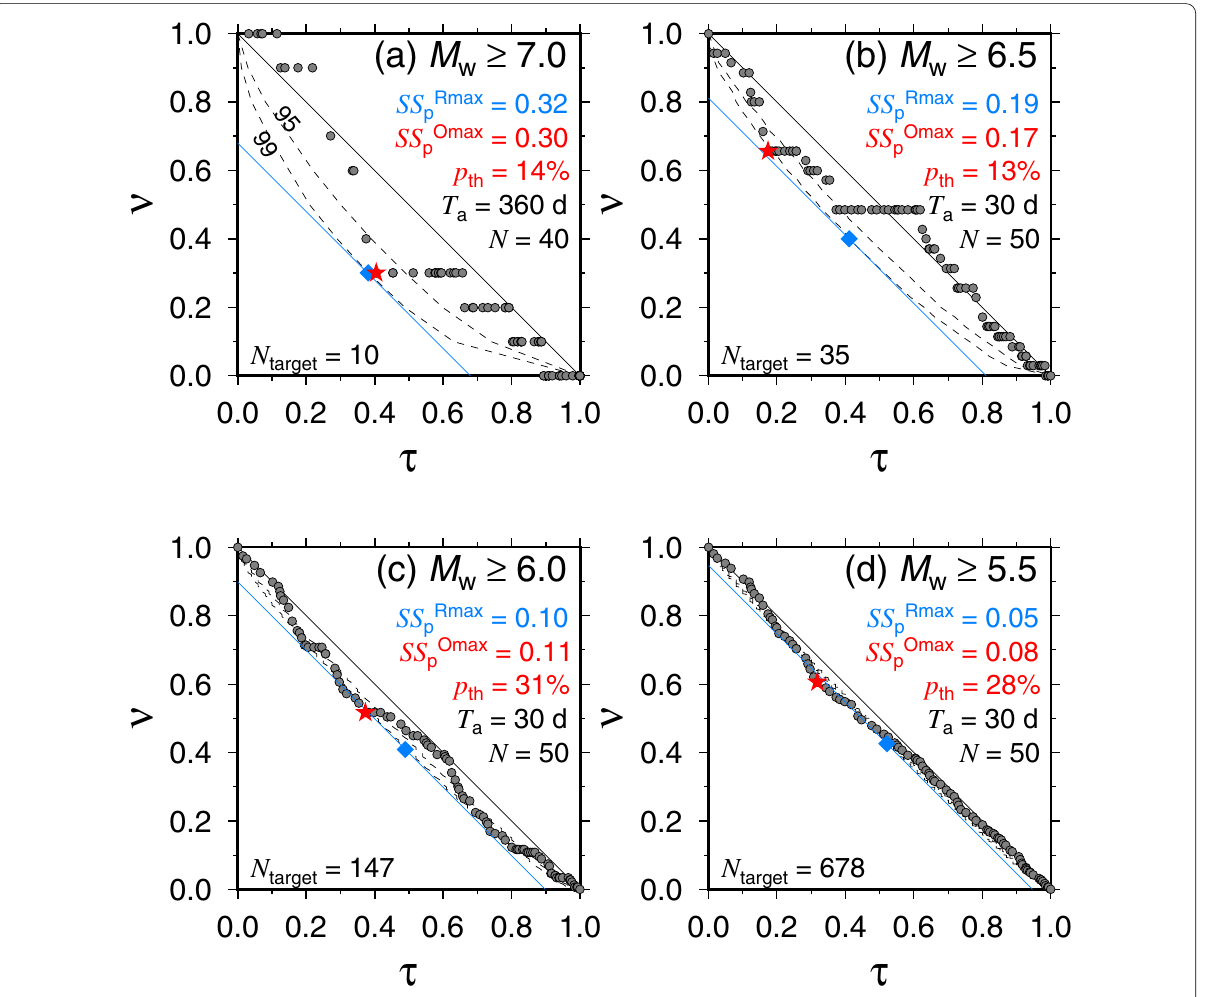
Fig. 4 Molchan’s error diagrams for target earthquakes of magnitude a M w p -value p th . For each target magnitude, the optimum forecast that maximizes SS P (Eq. 3) is shown. Dashed lines indicate 99 and 95% confidence intervals for random guessing (solid black lines). Red stars and blue diamonds indicate the maximum SS P values obtained for the forecast and random guessing, respectively. The blue line in each figure indicates the range satisfying the maximum SS P for a 99% confidence interval for random guessing; only forecasts that plot below this line are considered